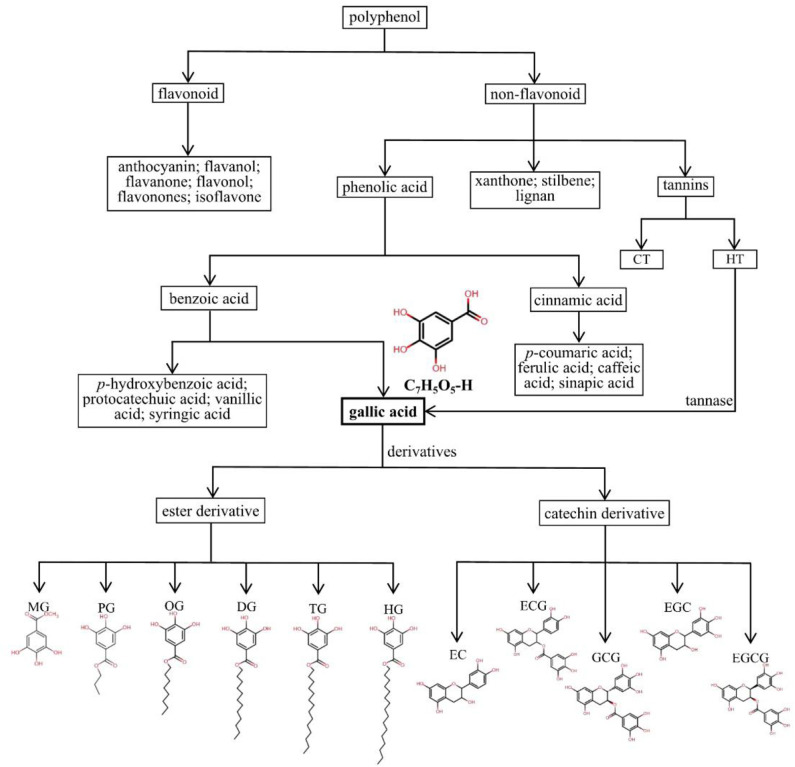
Detailed classification and chemical structures of polyphenols, phenolic acids, GA, and its derivatives. HTs, hydrolysable tannins; CTs, condensed tannins; MG, methyl gallate, C7H5O5-CH3; PG, propyl gallate, C7H5O5-(CH2)2-CH3; OG, octyl gallate, C7H5O5-(CH2)7-CH3; DG, dodecyl gallate, C7H5O5-(CH2)11-CH3; TG, tetradecyl gallate, C7H5O5-(CH2)13-CH3; HG, hexadecyl gallate, C7H5O5-(CH2)15-CH3; EC, epicatechin, C15H14O6; ECG, epicatechin gallate, C22H18O10; GCG, gallocatechin gallate, C22H18O11; EGC, epigallocatechin, C15H14O7; EGCG, epigallocatechin gallate, C22H18O11.